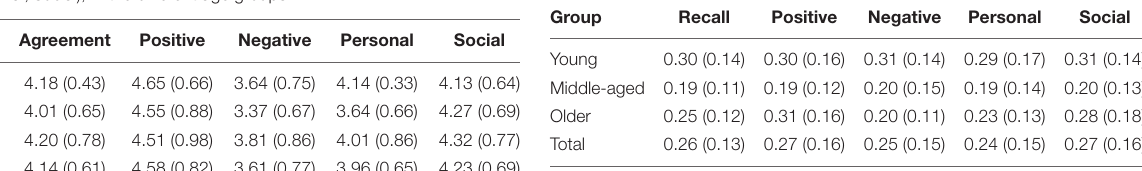
TABLE 1 | Mean proportion and standard deviations (in parentheses) in total agreement with the statements depending on their valence (positive, negative) and nature (personal, social), in the different age groups.